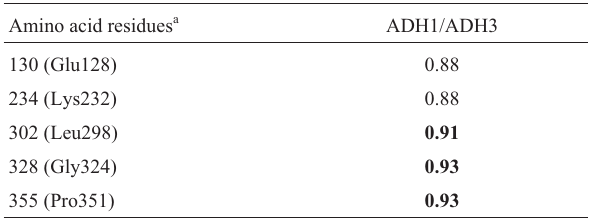
Table 5 - Amino acid residues important for the functional divergence be- tween ADH forms of